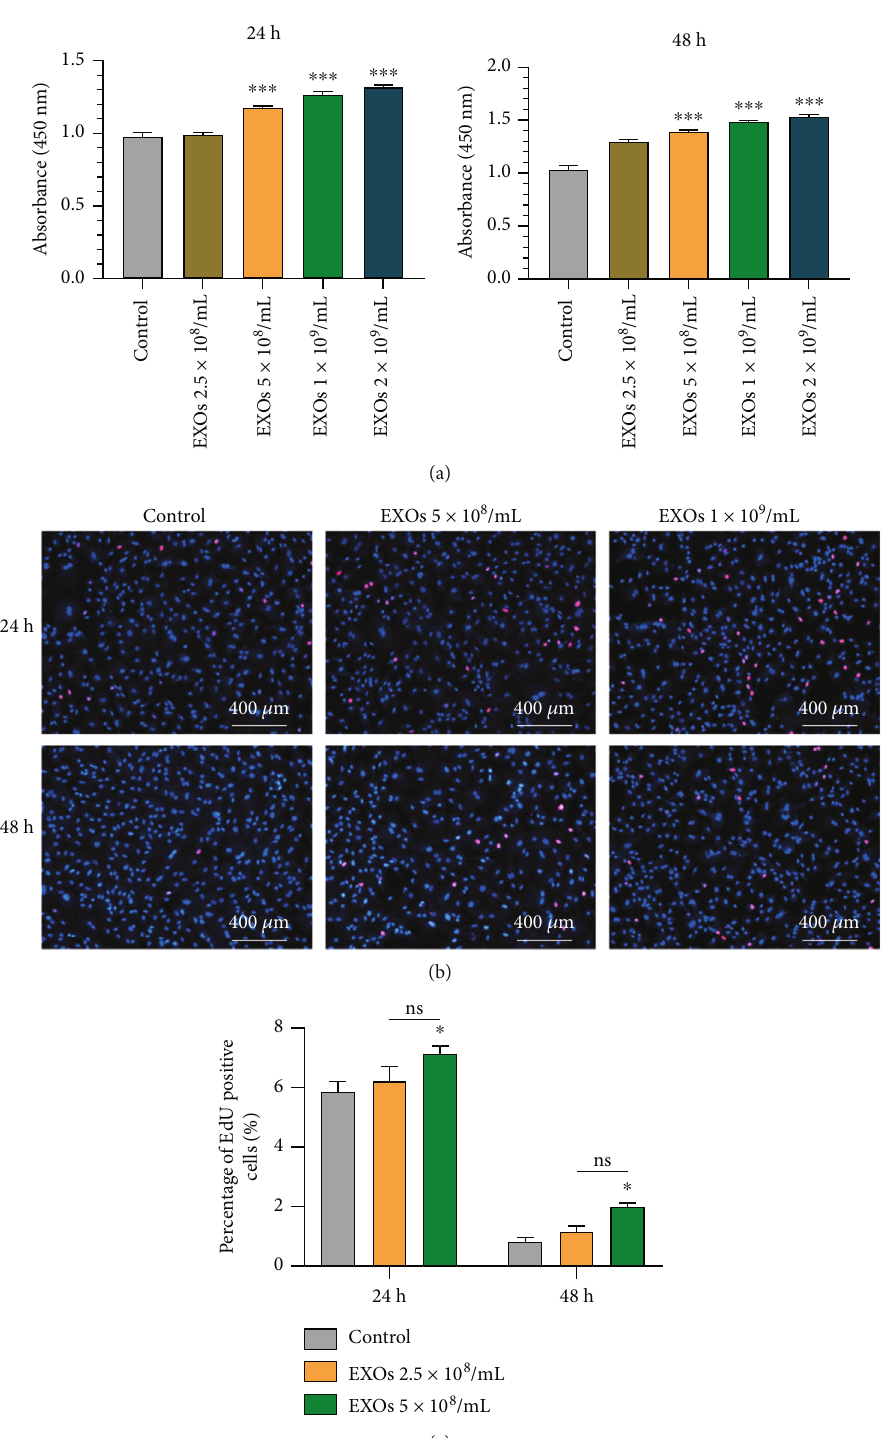
Figure 2: hBMSC-EXOs improve cell viability and proliferation in chondrocytes. Rabbit primary chondrocytes were treated with hBMSC- EXOs at di ff erent dosages as indicated. 24 h or 48 h posttreatment, cell proliferation and cell viability were examined. (a) Cell viability was increased by hBMSC-EXOs in chondrocytes. CCK-8 assay was used to analyze cell viability. n = 3 . (b) Cell proliferation was enhanced by hBMSC-EXOs in chondrocytes. Cell proliferation was assayed by EdU incorporation. n = 3 . Scale bar = 400 μ m . (c) Quantitative analysis for EdU incorporation as shown in (b). Values are presented as mean ± SEM . ns means no signi fi cance. ∗ P < 0 : 05 and ∗∗∗ P < 0 : 001 , versus the control group, one-way